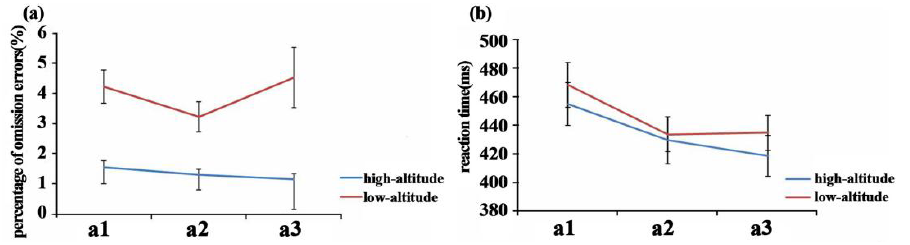
Figure 2. ( a ) The percentage of omission errors and ( b ) the mean of the reaction time on the two groups for the periods